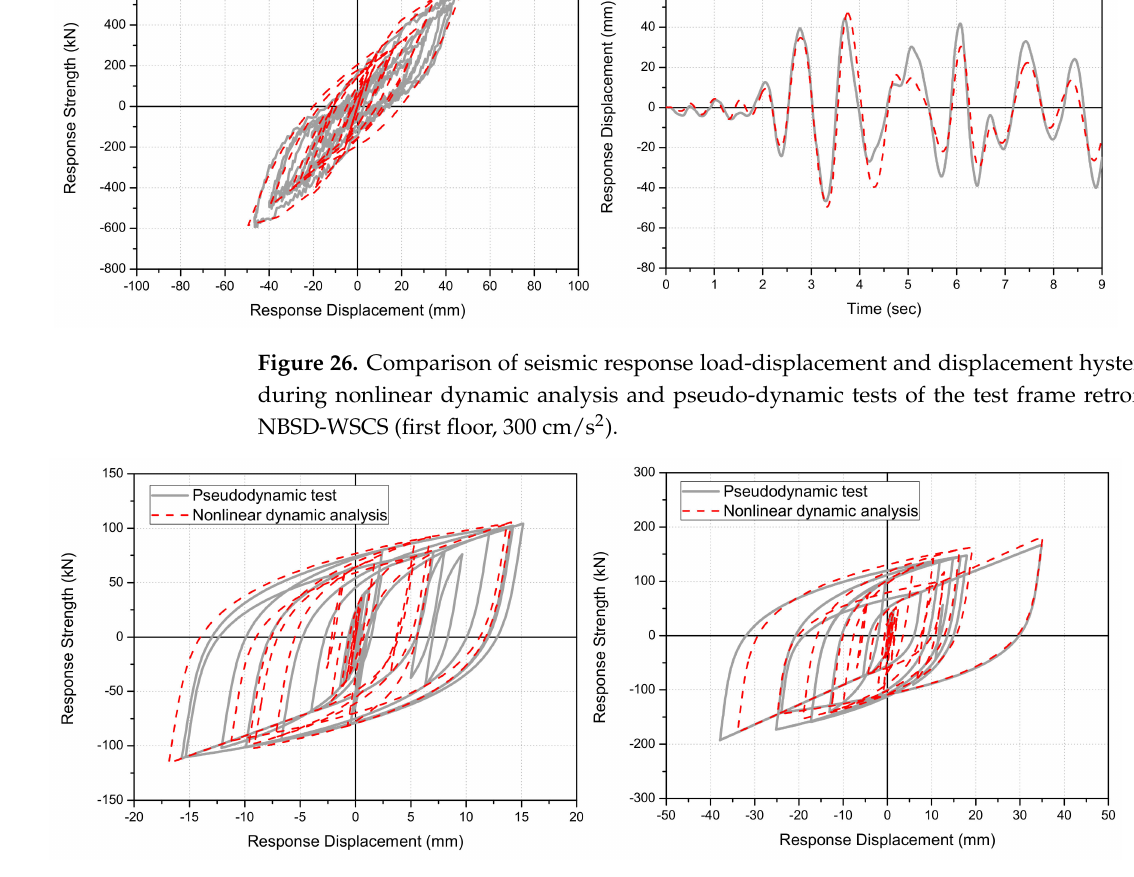
Figure 27. Comparison of seismic response load-displacement curves during nonlinear dynamic analysis and pseudo-dynamic tests of NBSD (first floor, 300 cm/s 2 ). Table 13. Comparison of maximum response load-displacement relationship between nonlinear dynamic analysis and pseudo-dynamic test